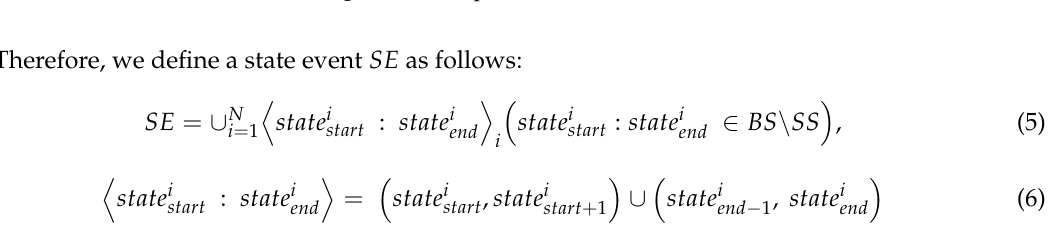
Figure 3. Example of a state event.